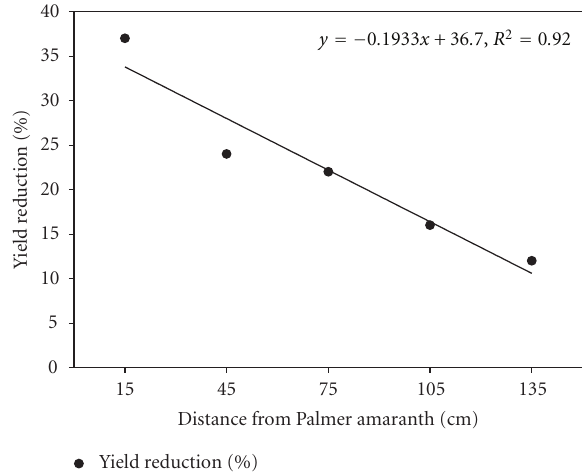
Figure 2: Percent reduction in soybean yield as influenced by dis- tance from Palmer amaranth in the field